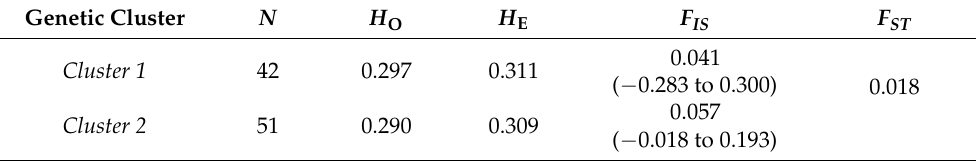
Table 1. Summary table of the statistics associated with fox cluster assignment. N refers to the number of foxes allocated to the respective cluster; H O refers to the total mean of the estimated observed heterozygosity per cluster; H E refers to the total mean of the estimated expected heterozygosity per cluster; F IS is the estimated inbreeding coefficient per cluster; F ST is the estimated pairwise F statistic estimated for the two clusters. Genetic Cluster N H O H E F IS F ST 0.041 Cluster 1 42 0.297 0.311 ( − 0.283 to 0.300) 0.018 0.057 Cluster 2 51 0.290 0.309 ( − 0.018 to